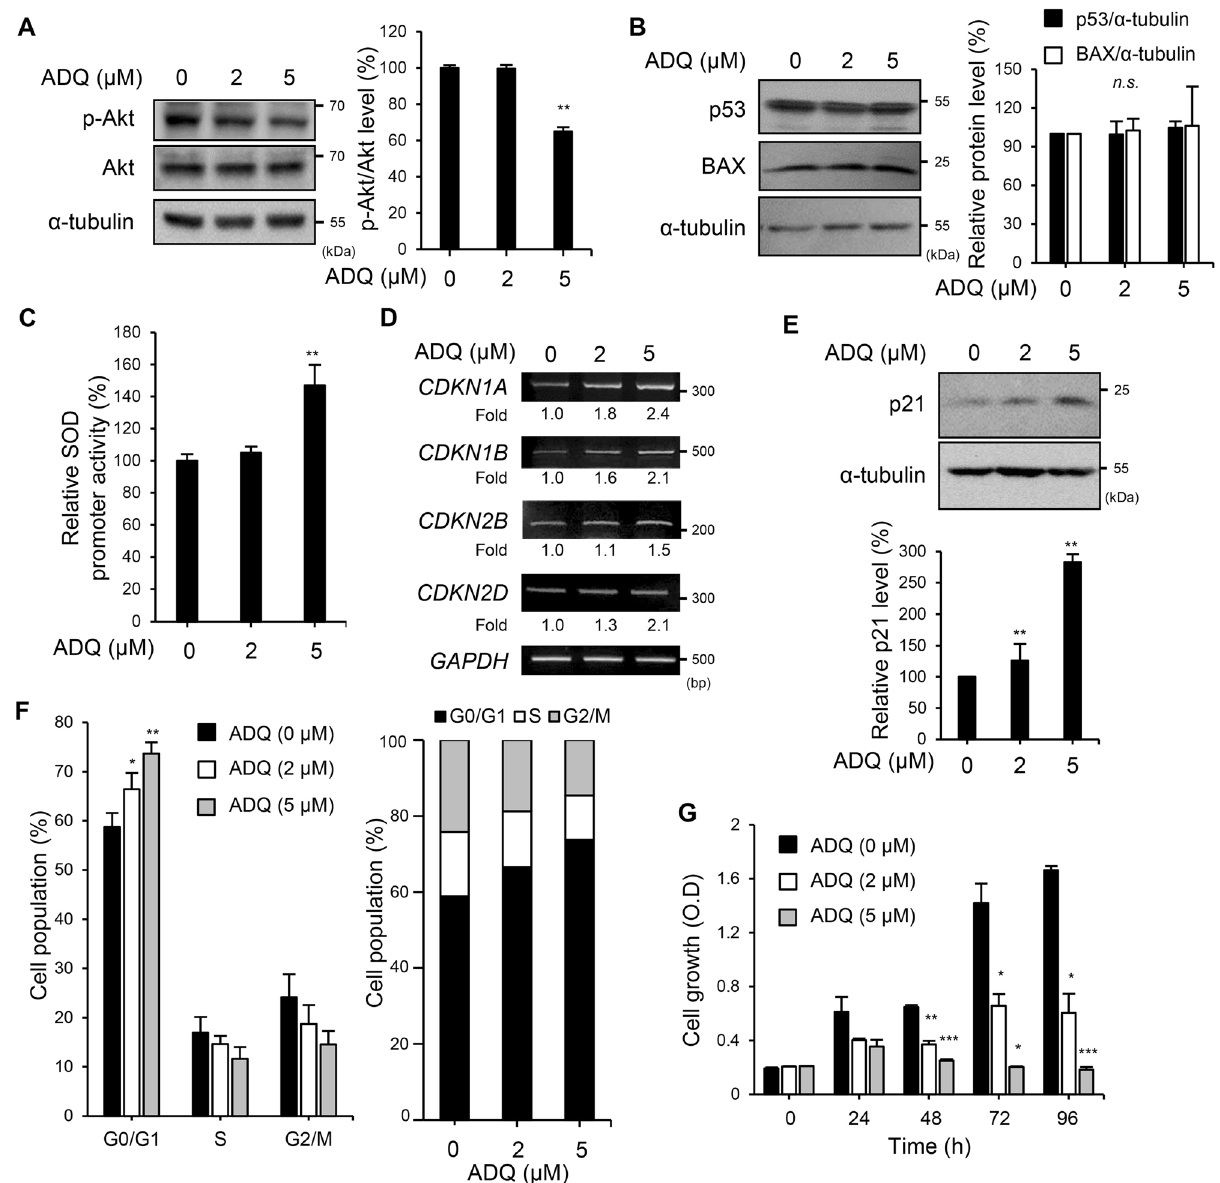
Figure 3. The Akt signaling pathway and its downstream effectors were altered by ADQ. SK-Hep1 cells were treated with ADQ for 24 h in 10% FBS-containing media. ( A ) The expression levels of p-Akt (Ser473), Akt, and α-tubulin were detected by specific antibodies. ( B ) The expression levels of p53, BAX, and α-tubulin were detected by specific antibodies. ( C ) SK-Hep1 cells were co-transfected with the pSOD-Luc reporter and gWIZ- GFP. The cells were treated with the indicated concentrations of ADQ for 24 h in culture media containing 10% FBS. The luciferase activities were normalized against the GFP levels. ( D ) The transcription levels of CDKN1A , CDKN1B , CDKN2B , CDKN2D , and GAPDH were analyzed by RT-PCR. ( E ) The expression levels of p21 and α-tubulin were detected by specific antibodies. ( F ) The cells were harvested after 24 h of incubation with ADQ in 10% FBS media and analyzed. The bar graph shows the distribution of cells in the different phases of the cell cycle. ( G ) SK-Hep1 cells (1500 cells/well) were seeded in 96-well plates. Cells were treated with the indicated concentration of ADQ in media containing 10% FBS. At each indicated time point, cellular growth was measured using the Ez-Cytox solution. Data are representative of three experiments and expressed as the means ± SEM. Data were analyzed by one-way ANOVA followed by Holm-Šídák’s post hoc test; *p < 0.05, **p < 0.01, and ***p < .001 relative to the ADQ-untreated